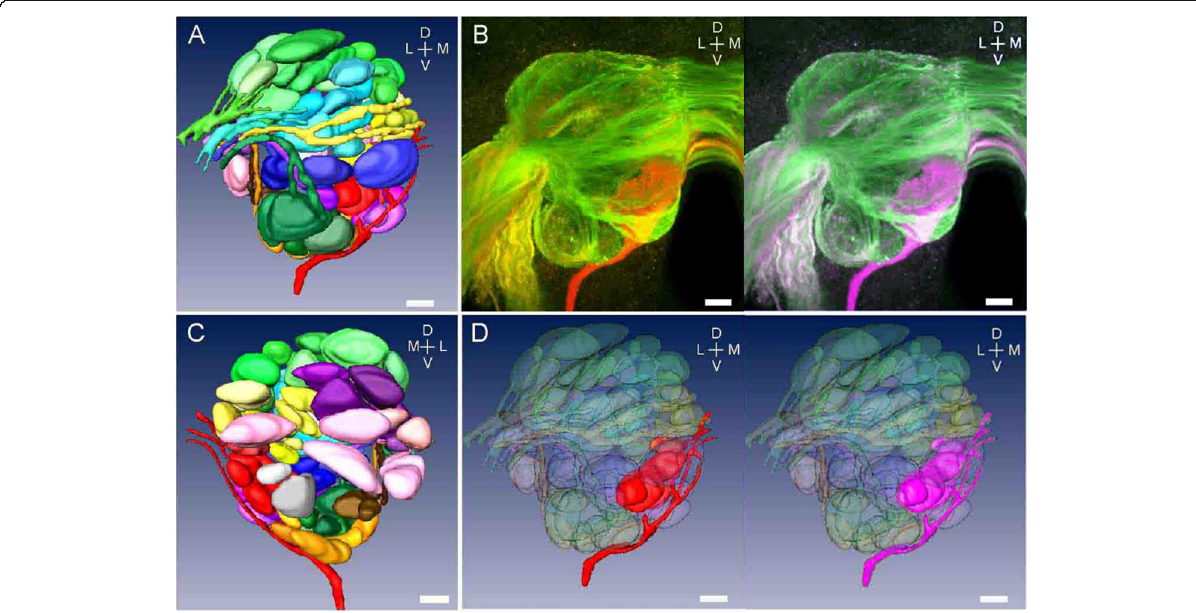
Fig. 3 A projection of the confocal images and reconstructed glomerular structure and tracts. a and c , respectively, show anterior and posterior aspects of the reconstructed right AL. Most glomeruli are categorized into subdivisions using the innervation pattern of the tracts (see Table 1). b shows antennal ORNs (green or cyan) and maxillary ORNs (red or magenta) projecting to the right AL. d shows glomeruli projecting from the maxillary palps (red or magenta) with transparent images of glomeruli projected from the antennae. Bars indicate 20 μ